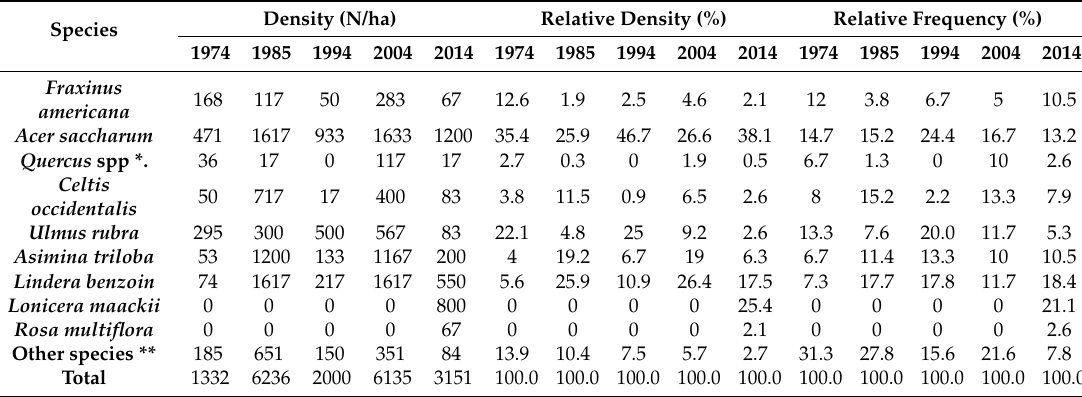
Table 6. Density (N/ha), Relative Density, and Relative Frequency for the dominant woody species recorded in the seedling class (Height ≤ 1.4 m) at Dinsmore Woods across the five sampling